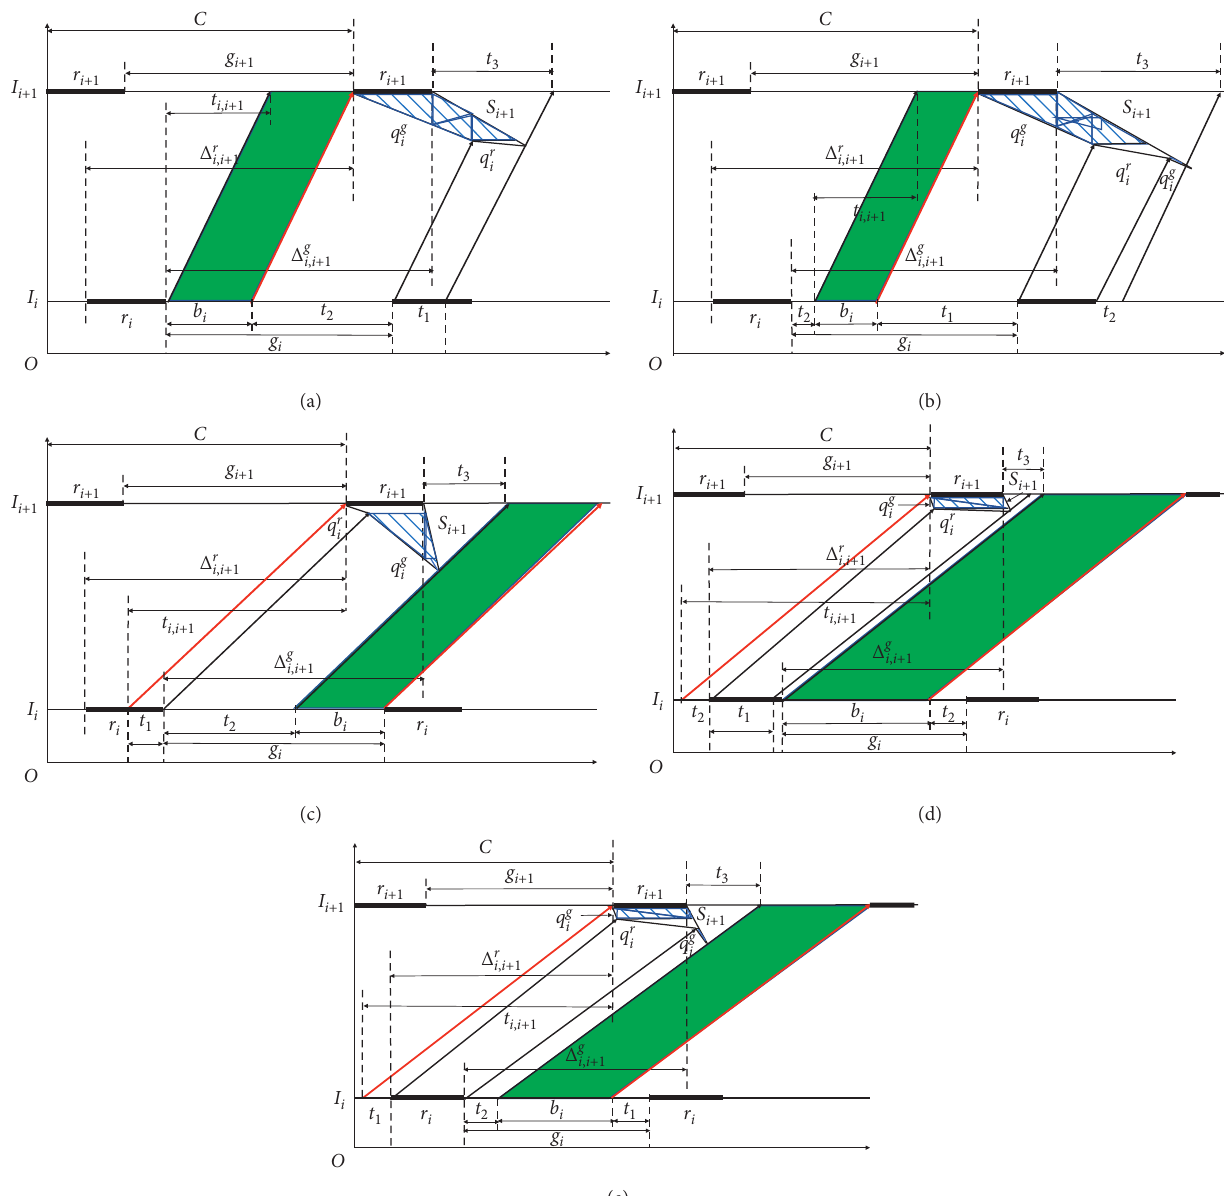
Figure 6: Five categories of backward overlapping spatiotemporal subplots.